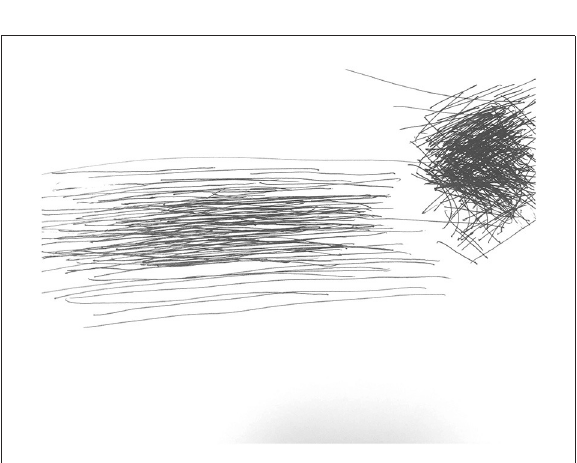
FIGURE4 Amsterdam: Walkers, Bikers, Cars. Drawn by: Michael